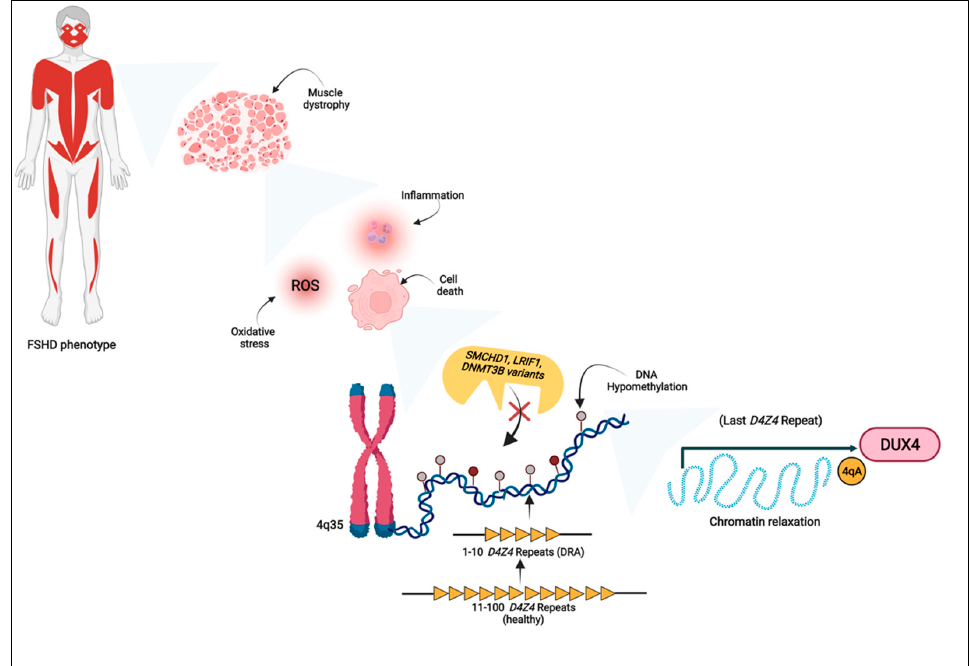
Figure 1. The main disease mechanisms and molecular determinants involved in FSHD etiopathogenesis. The figure illustrates how the FSHD phenotype results from the muscle dystrophy and dysfunction, which, in turn, are due to altered biological mechanisms such as cell death, inflammation and oxidative stress. The dysregulation of such pathways has been associated with DUX4 toxic expression. In presence of a 4qA permissive allele, DUX4 activation depends on the chromatin relaxation of the D4Z4 array that can result from the partial deletion of the D4Z4 repeated units, the occurrence of pathogenic variants within SMCHD1 , LRIF1 and DNMT3B genes and the concomitant DNA hypomethylation. DRA: D4Z4 reduced allele; ROS: reactive oxygen species. Created with Biorender.com, accessed on 15 July 2022.